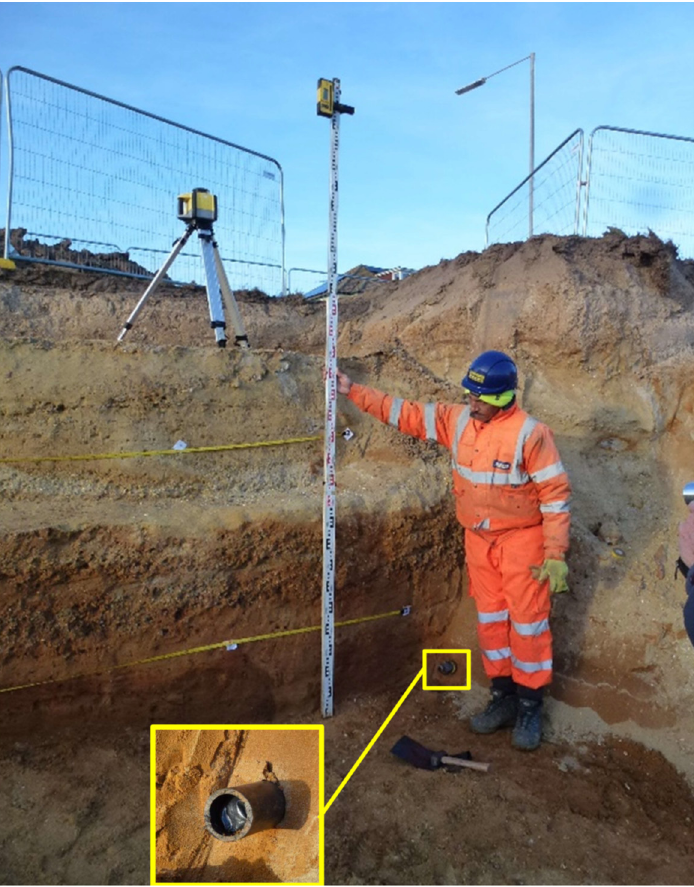
Figure 8. Temporary cliff-top section at Holland-on-Sea, Essex, showing stratigraphy and sampling for luminescence dating (inset). Tendring District Council encouraged research on the site as part of their stakeholder engagement with local interest groups, which was facilitated by Mott MacDonald, the overall developers of the scheme, and their contractors, Jacksons. Table 2. Radionuclide concentrations and total dose